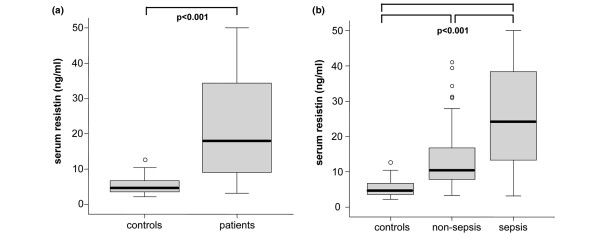
Serum resistin concentrations in critically ill patients. (a) Serum resistin levels are significantly (P < 0.001, U-test) elevated in all patients in the intensive care unit (n = 170) as compared with healthy controls (n = 60). (b) Serum resistin levels are significantly (P < 0.001, U-test) higher in sepsis patients (n = 122) as compared with non-sepsis (n = 48) patients. Box plots are displayed, where the bold black line indicates the median per group, the box represents 50% of the values, and horizontal lines show minimum and maximum values of the calculated non-outlier values; open circles indicate outlier values.